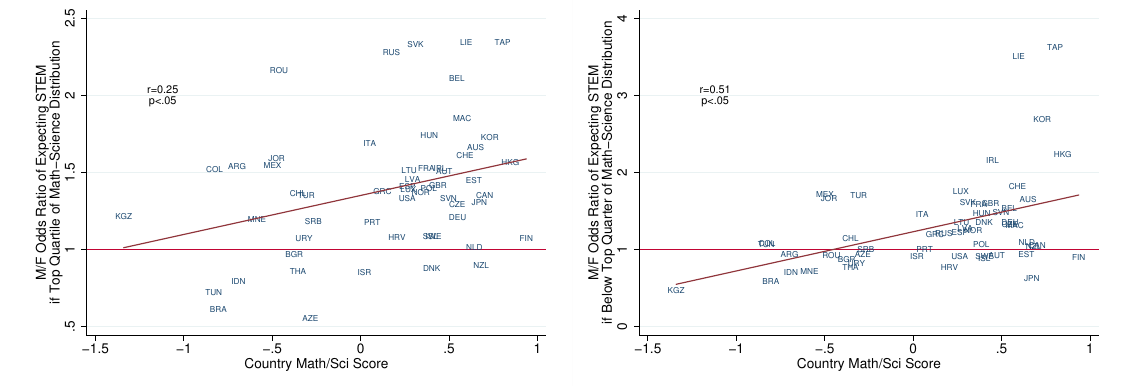
Figure 8: Odds ratio for male and female students that a student is STEM-oriented, given that the student is a top- or bottom-performing student in math and science, by the national math-science performance level (reference line represents even M–F